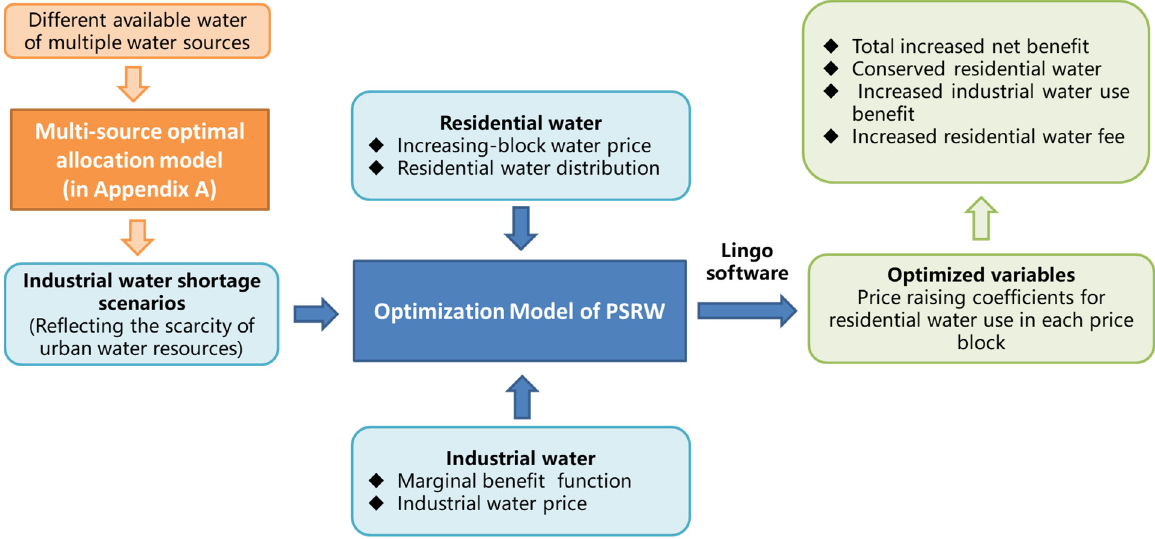
Figure 5. The solving process of the optimization model of PSRW.